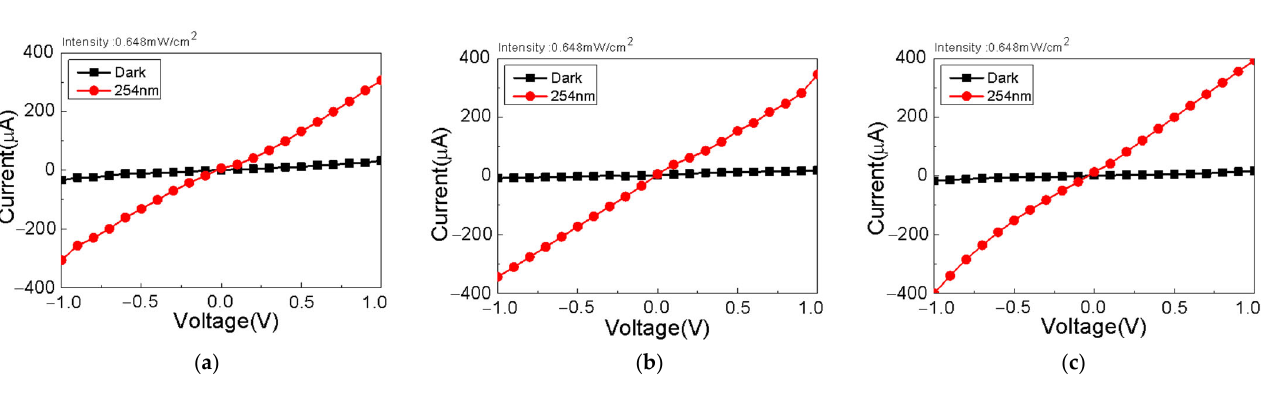
Figure 5. Current–voltage curves of FAPbX 3 ‐ MAPbX 3 (X = I, Br, and Cl) photodetectors with different halides: ( a ) X = I, ( b ) X = Br, and ( c ) X = Cl.